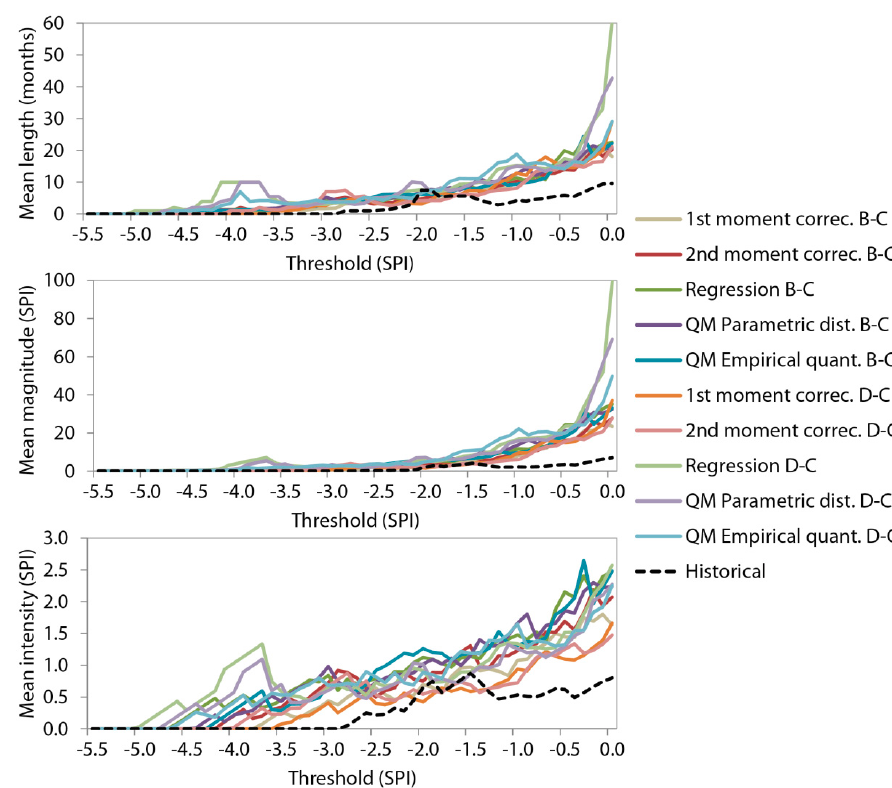
Figure 10. Drought statistics of future precipitation series for the HIRHAM5 RCM model nested inside EC-EARTH GCM—lumped approaches.